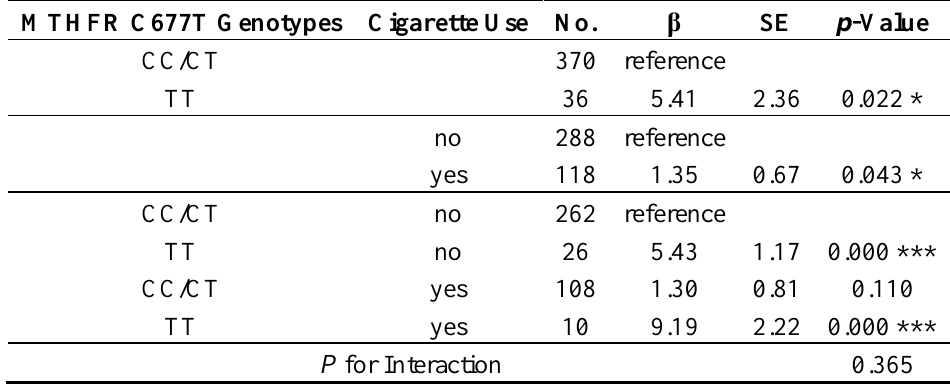
Table 4. The relative and joint effects of MTHFR genotype and cigarette use on homocysteine levels ( n = 406) †